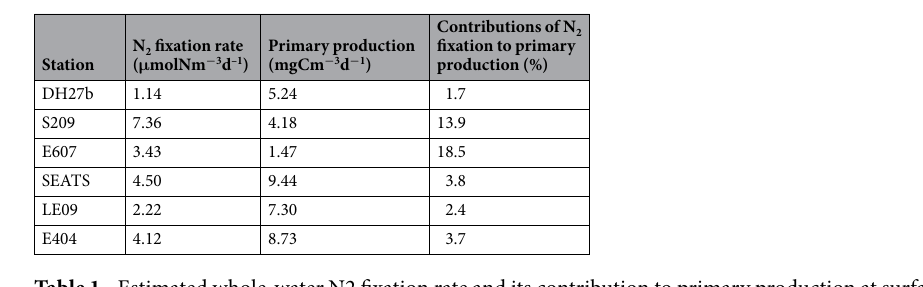
Table 1. Estimated whole-water N2 fixation rate and its contribution to primary production at surface water.